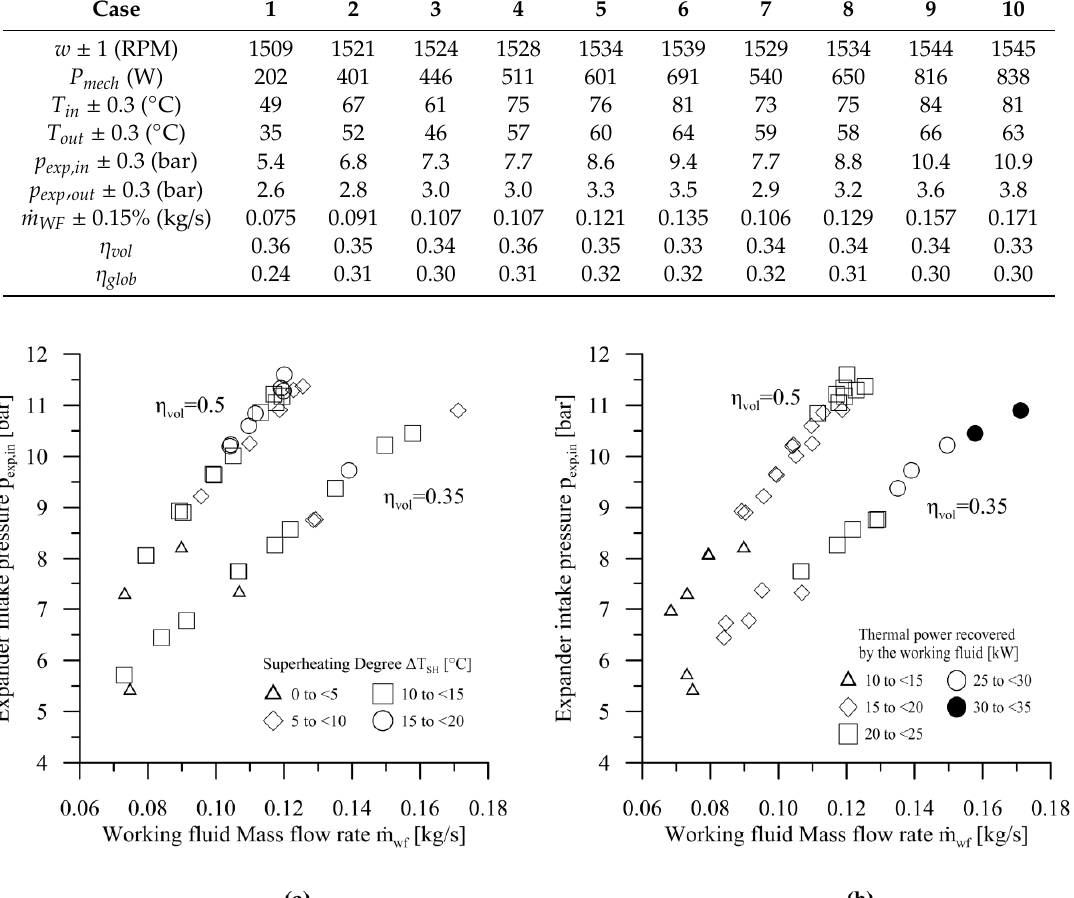
Figure 3. ( a ) Effect of the expander volumetric efficiency on intake pressure variation as a function of Figure 3. ( a ) E ff ect of the expander volumetric e ffi ciency on intake pressure variation as a function of the mass flow rate for different values of superheating degree; and ( b ) effect of the expander the mass flow rate for di ff erent values of superheating degree; and ( b ) e ff ect of the expander volumetric volumetric efficiency on the thermal power recovered by the working fluid. e ffi ciency on the thermal power recovered by the working